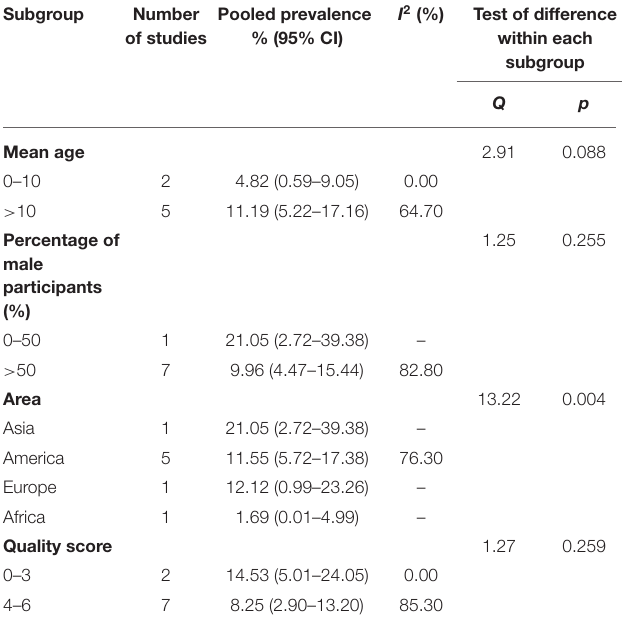
TABLE 3 | Subgroup analysis for taste